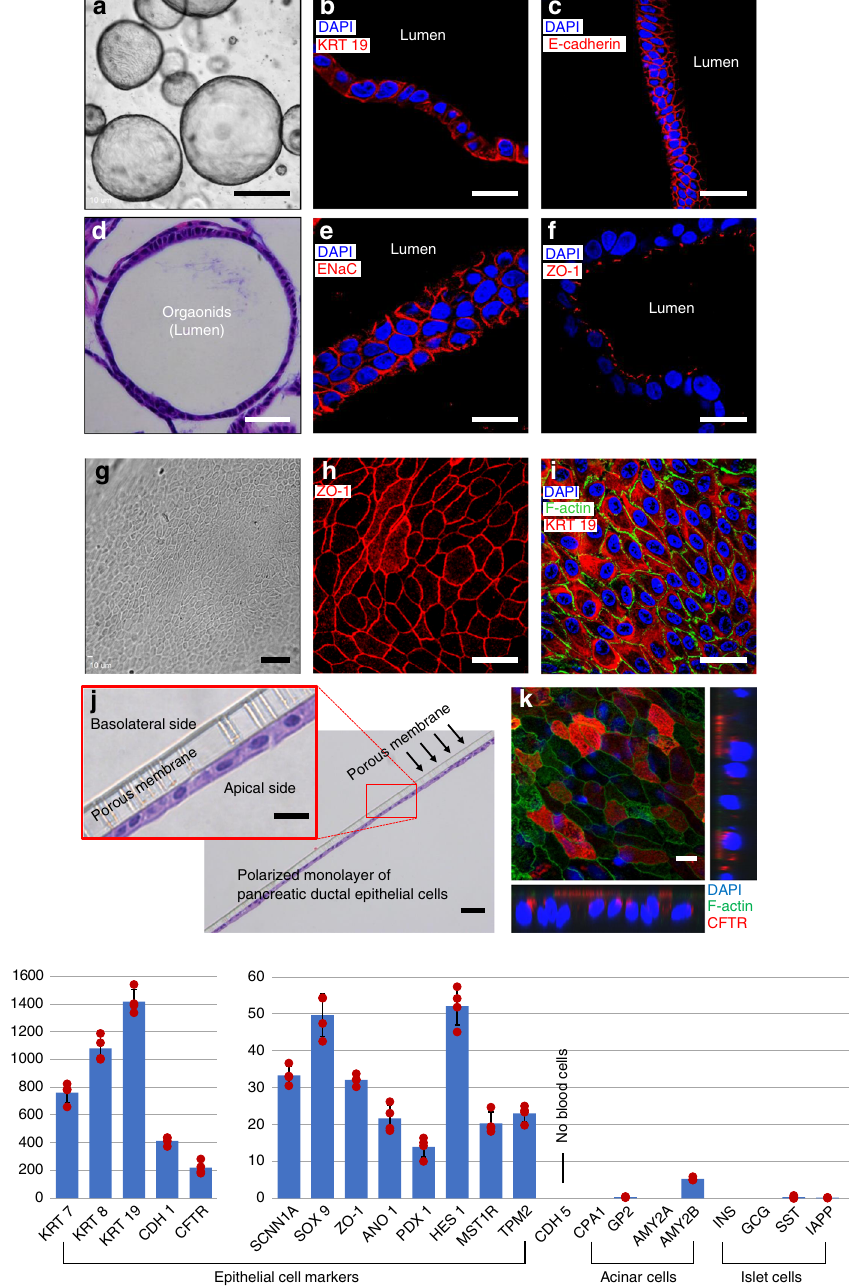
Fig. 2 Characterization of pancreatic ductal epithelial cells. ( a – f , l : Characterization of organoids). a Characterization of pancreatic ductal organoids using epithelial cell markers, b cytokeratin 19 (KRT 19, c E-cadherin, e sodium transport channel (ENaC), and f ZO-1. d Hematoxylin and eosin (H&E) image shows the orientation of pancreatic ductal epithelial cells in spheroid of the organoid. ( g – k : Characterization of monolayer of pancreatic ductal epithelial cells (PDECs)). g Phase contrast and j H&E images show monolayer of PDECs formed from the organoids. Monolayer of PDECs showed positivity for tight junction h ZO-1, i F-actin and KRT 19, and k cystic fi brosis transmembrane conductance regulator (CFTR). l RNA-sequencing data was obtained from the pancreatic ductal organoids and veri fi ed the PDEC origin ( n = 4 sample preparation from the same patient). Data are mean ± SD. Scale bars: 10 µ m ( k ), 20 µ m ( b , c , e , f , h – j enlarge), 50 µ m ( d , g , j ), and 500 µ m ( a